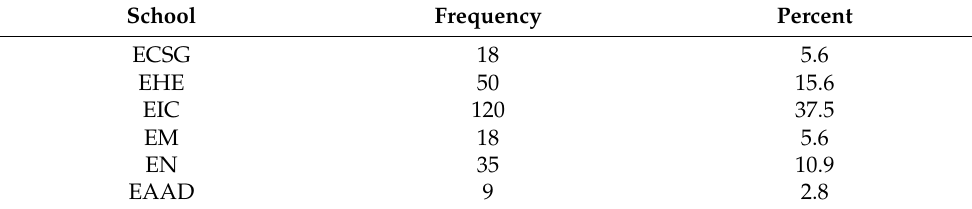
Table 3 qualifies the competence levels. Table 2. Frequency and Percentage of Professors by School (N = 250).